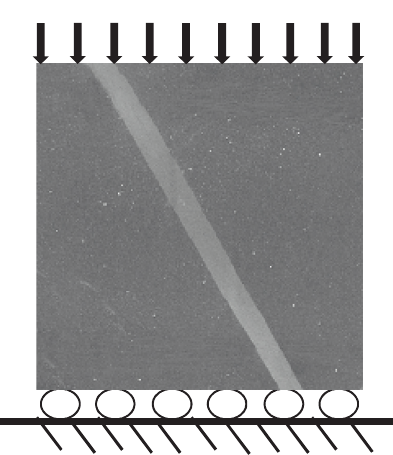
Figure 6: Mechanical loading diagram of the numerical model.